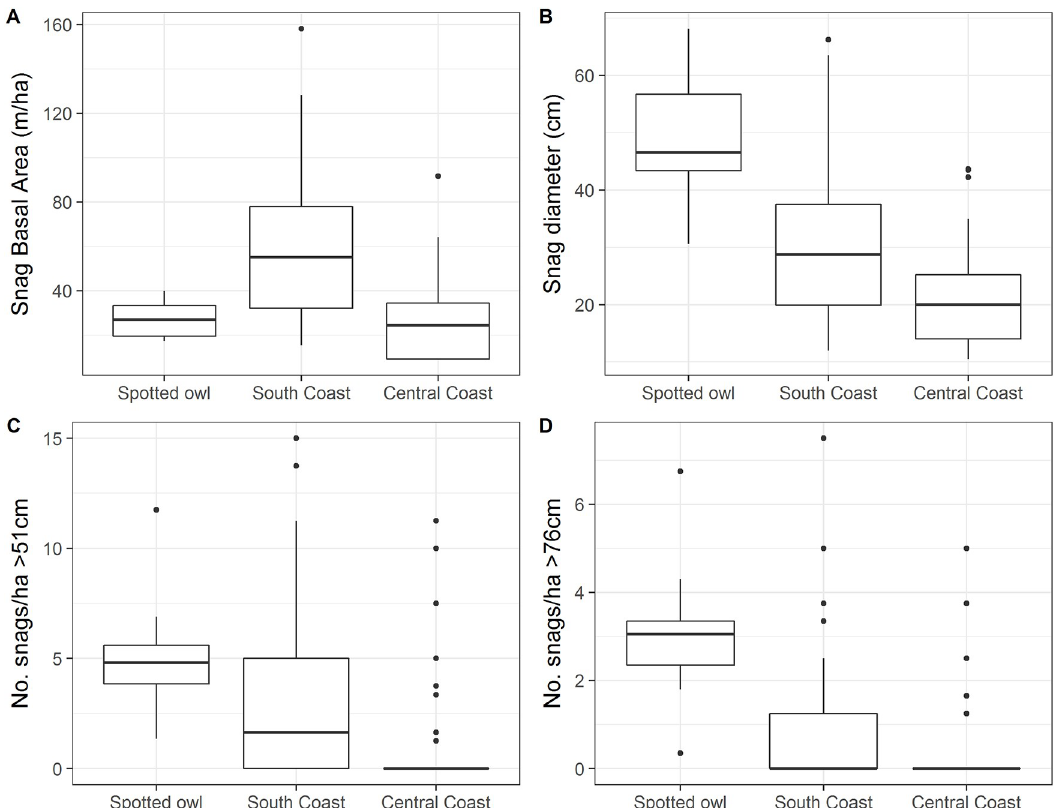
Fig 3. Vegetation data—Snag. Comparison of snag metrics at northern spotted owls’ ( Strix occidentalis caurina ) and a coastal subspecies of Pacific marten ( Martes caurina humboldtensis ) sites in coastal Oregon. Box plots show maximum and minimum values (end of lines or extreme points), first and third quartiles (top and bottom line of box), and the median (line within box).